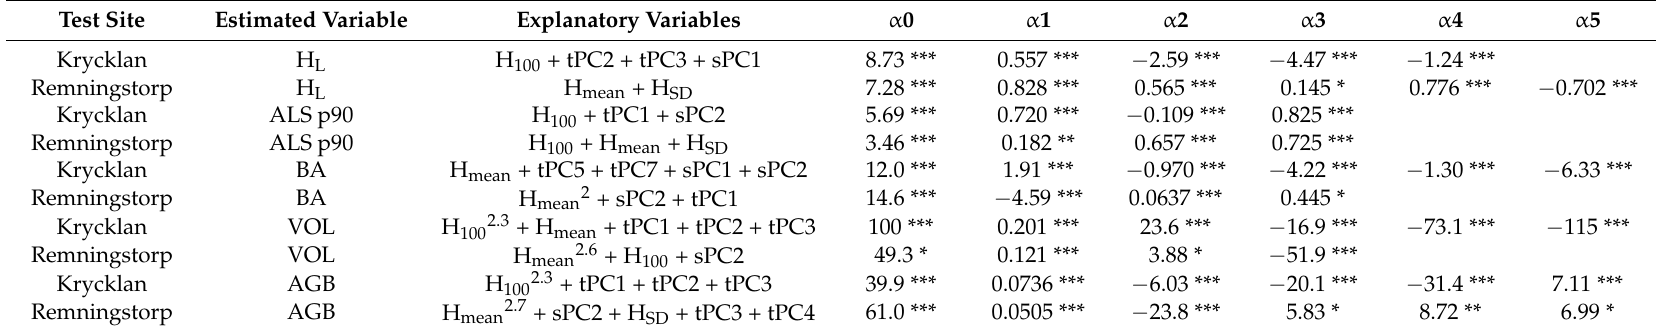
Table A1. Coefficients and significance levels (*** = p ≤ 0.001, ** = p ≤ 0.01, * = p ≤ 0.05) for the complete models from Group 4. α 0 denotes the intercept while the following α denotes the explanatory variables in the same